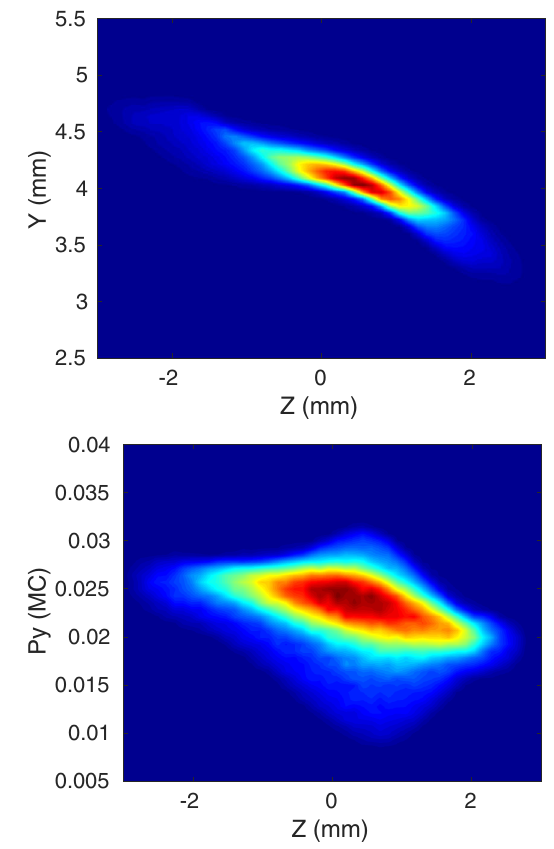
FIG. 6. Particle distribution of a beam emitted 2.0 mm off-axis at the cathode, after tracking to the exit of the injector shown in Fig. 1. Transverse-longitudinal correlations are visible in the final beam phase space. Here color denotes particle density, with red-black denoting regions of highest particle density and blue denoting regions of lowest particle density. (Upper) Z-Y projec- tion. (Lower) Z-Py projection.